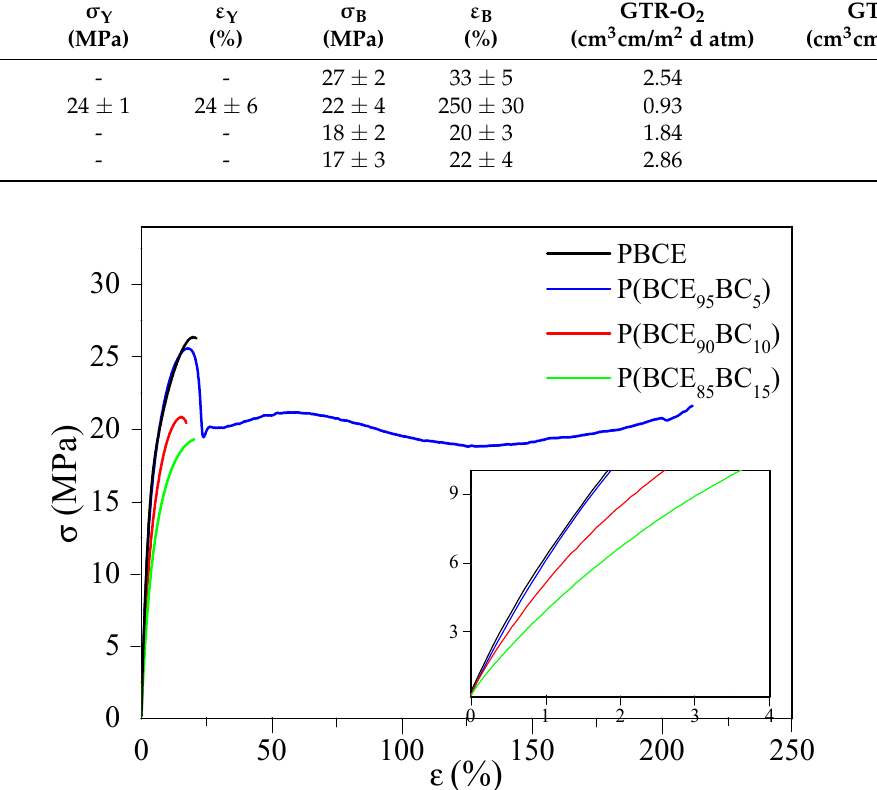
Table 3. Mechanical and gas barrier data of PBCE homopolymer and P(BCE x BC y ) copolymers. Polymer